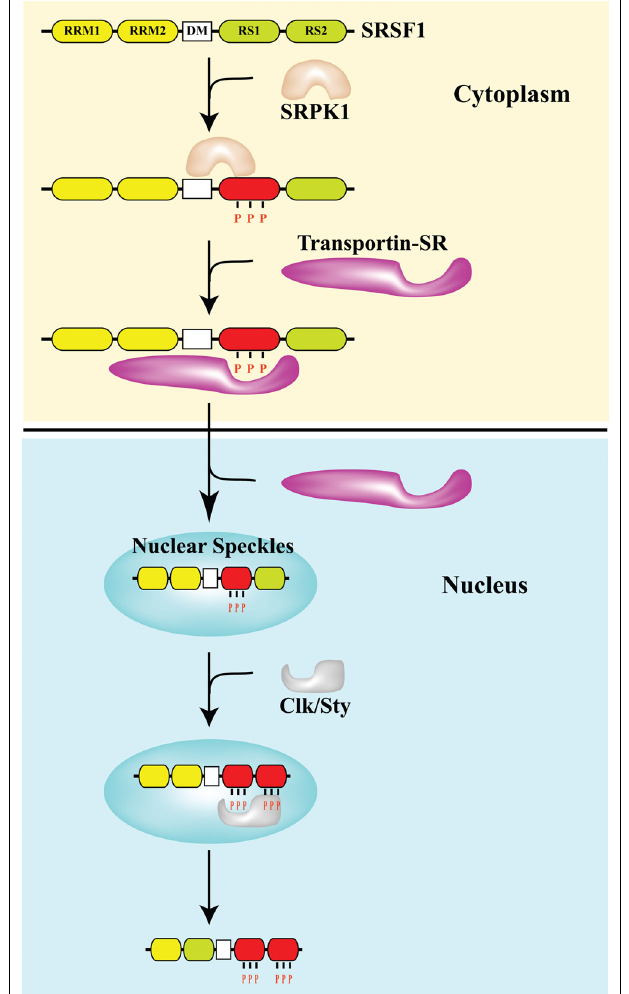
FIGURE 1 | Phosphorylation controls the subcellular distribution of splicing factor SRSF1. The arginine–serine (RS)-rich domain of the SR protein SRSF1 is phosphorylated by SR protein kinases SRPK and Clk/Sty. The docking motif (DM) restricts phosphorylation of SRSF1 by SRPK1 at the N-terminal portion of the RS domain (RS1), which is required for the interaction with transportin SR and nuclear import. In the nucleus, SRSF1 accumulates in nuclear speckles. Clk/Sty causes release of SRSF1 from speckles by phosphorylating the C-terminal portion of its RS domain (RS2; Ngo etal.,